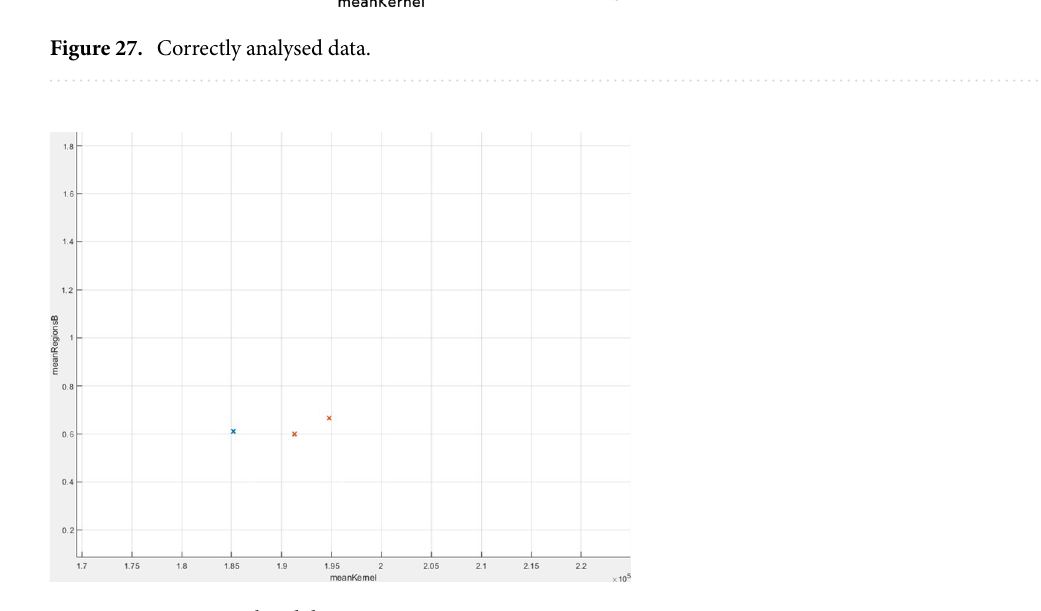
Figure 28. Wrong analysed